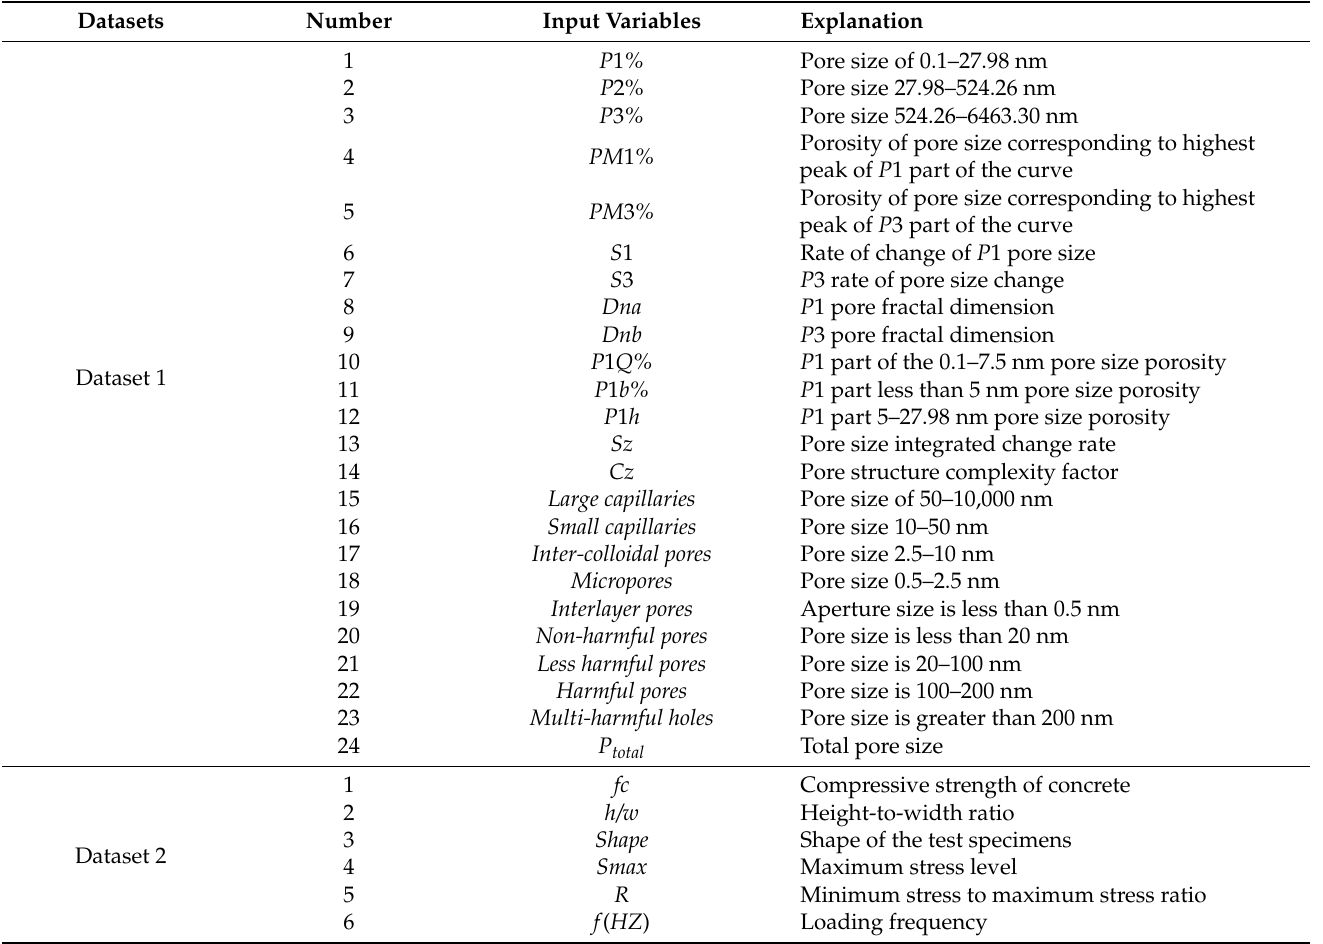
Table 1. Explanation of the meaning of the input variables in the